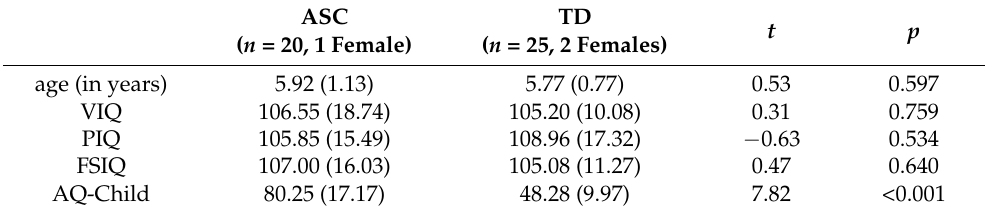
Table 3. Demographics (mean ± SD) of the ASC and TD groups in Experiment 2. ASC ( n = 20, 1